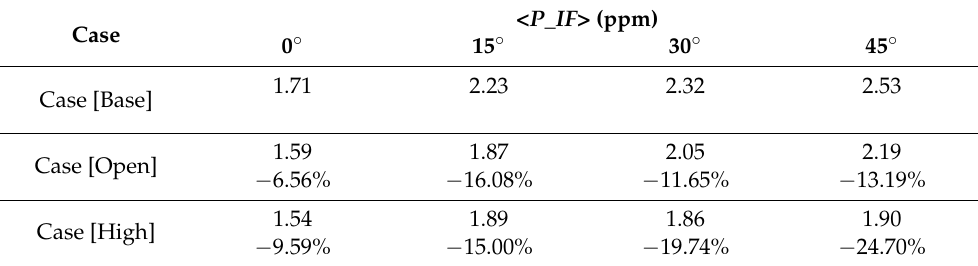
Table A7. Building intake fraction < P_IF > and the change rate in different